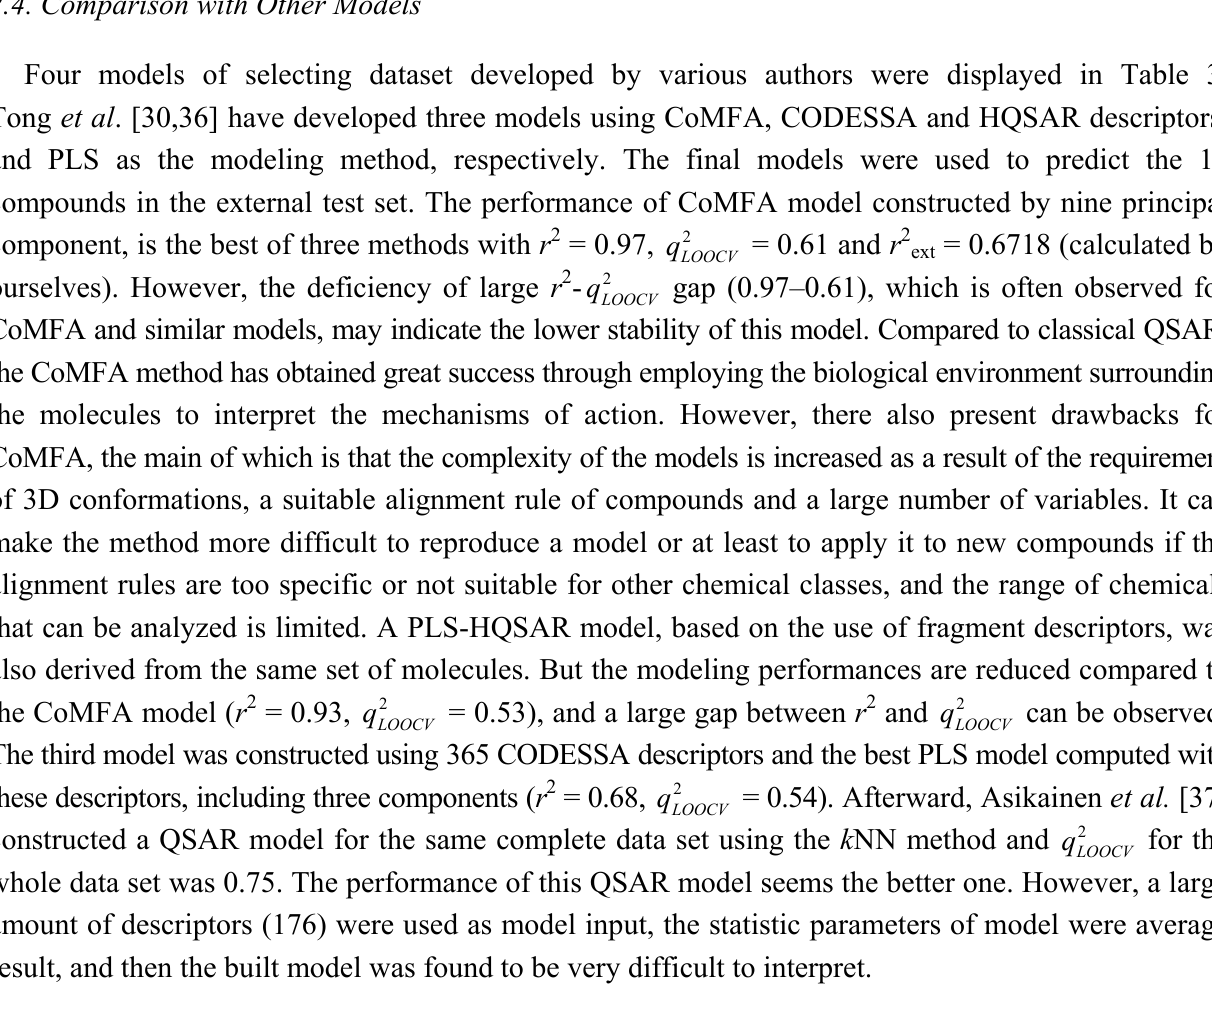
Table 3. Comparison with various